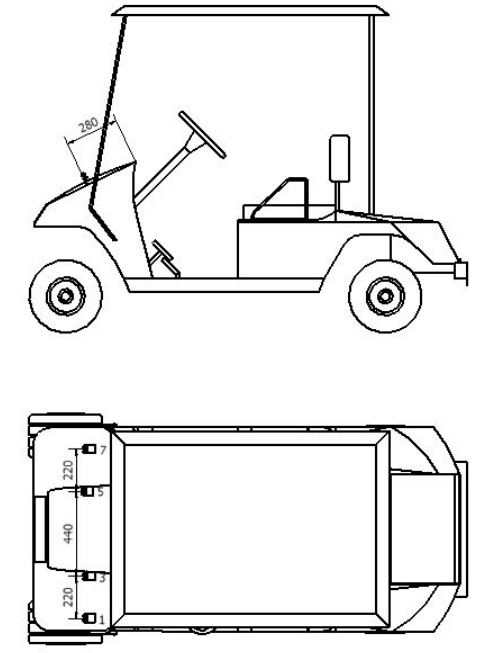
Figure 2. Image of the vehicle with the sonar system. The distances are given in